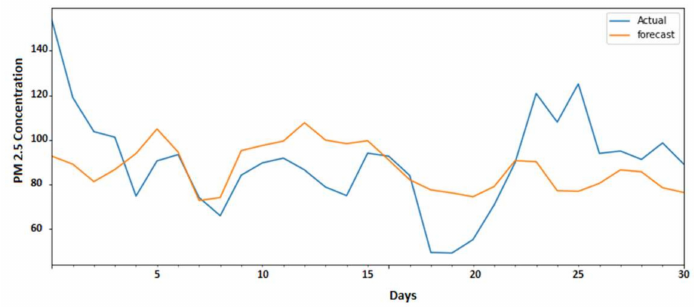
Figure 16. Forecasting for the next month for Islamabad using the multivariate FbProphet model.